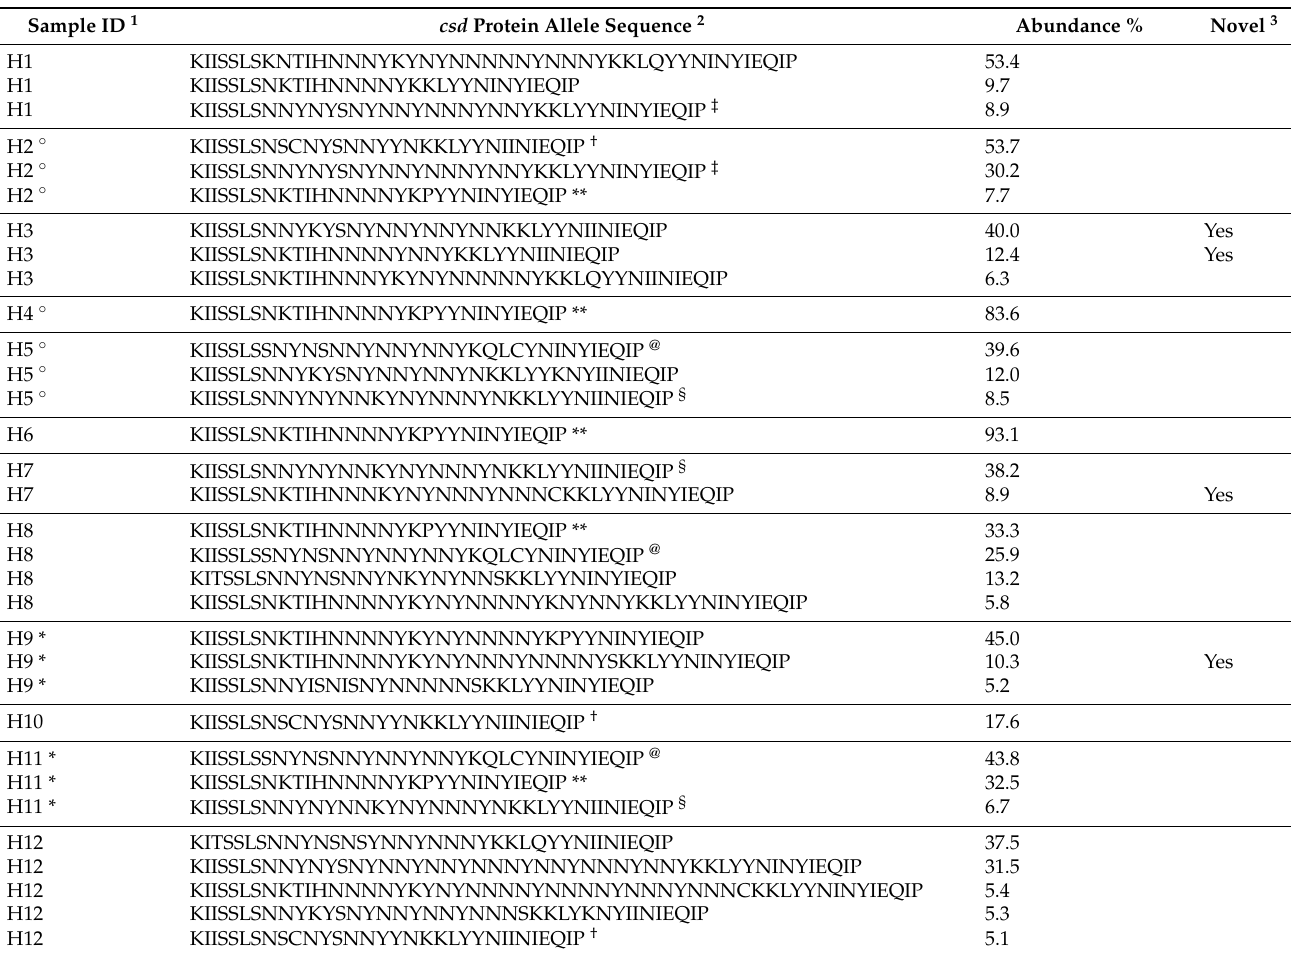
Table 2. Most abundant csd alleles (>5%) identified in the analyzed honey samples. Data are sorted by sample ID and by relative